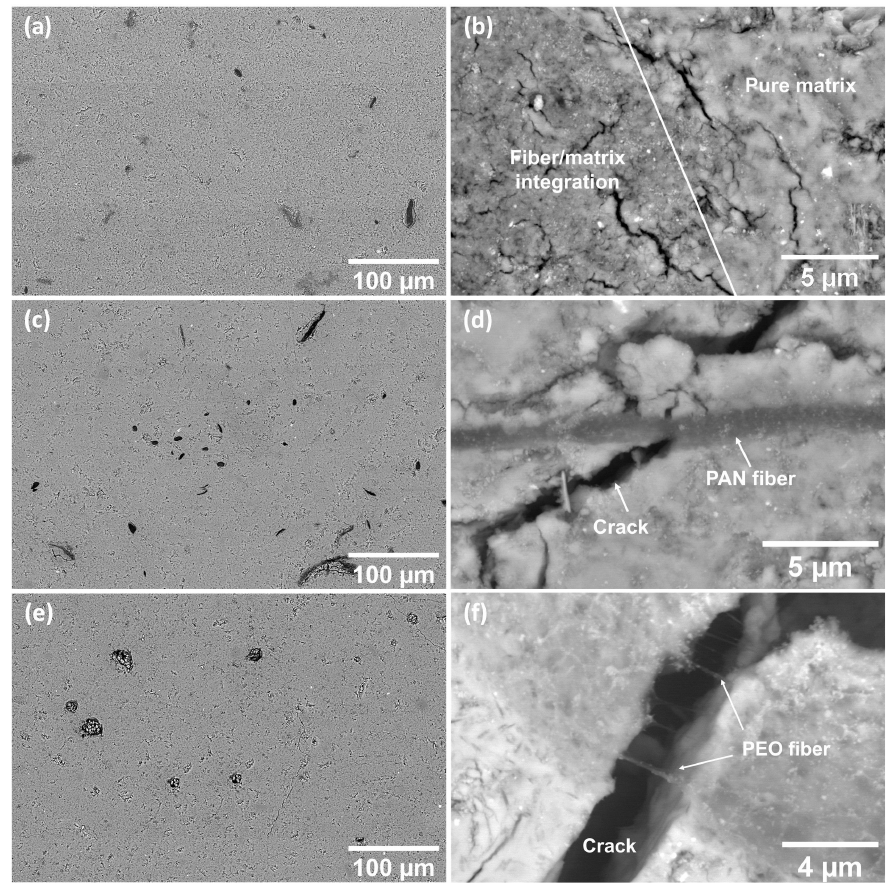
Figure 4. SEM images of electrospun-fiber-reinforced geopolymer composites: ( a , b ) KGP-0.5%PAN- W. ( c , d ) KGP-0.5%PAN-WG. ( e , f )